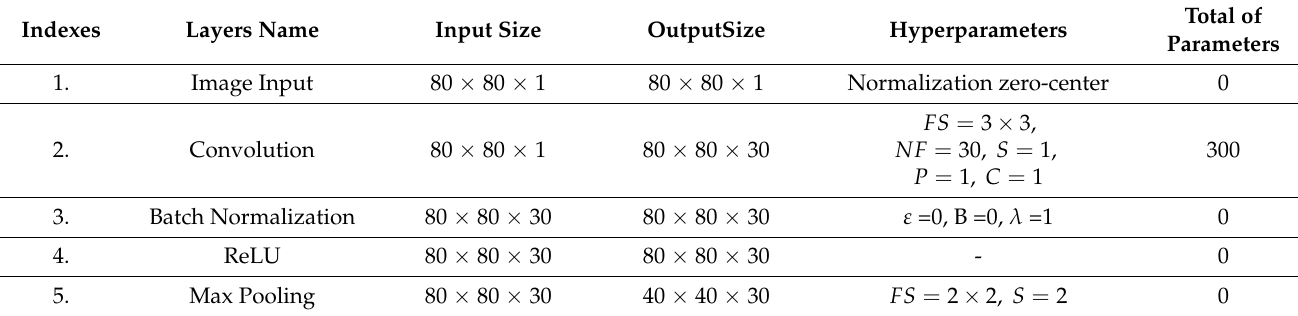
Table A1. Topology of the proposed CNN